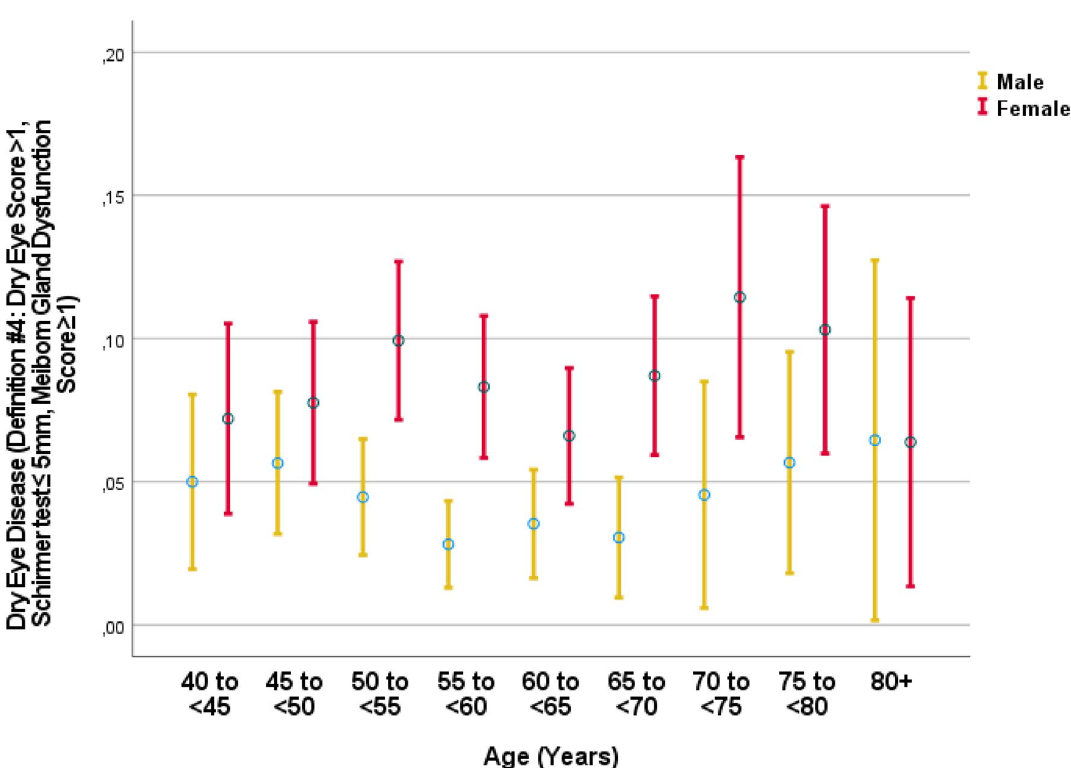
Figure 5. Graph showing the distribution of the prevalence of dry eye disease (definition #4: dry eye symptoms score was ≥ 1, Schirmer test ≤ 5 mm, and a Meibomian gland dysfunction grade of 1 (telangiectasia at the lid margin) or higher) stratified by age in the Ural Very Old